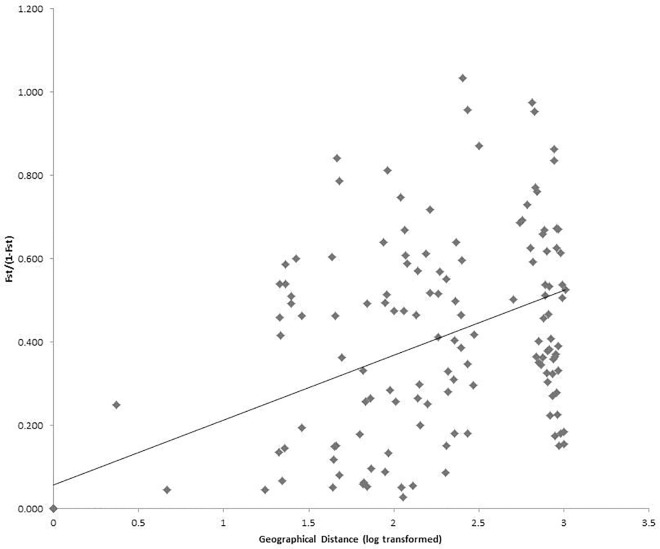
Scatterplot between genetic distance and geographic distance for Stipa purpurea populations.Genetic distance is represented by pairwise FST/(1–FST) among populations, which is correlated with the geographic distance between pairwise populations. The Pearson’s regression line overlays the scatterplot (Mantel-test, R2 = 0.21, p < 0.001).